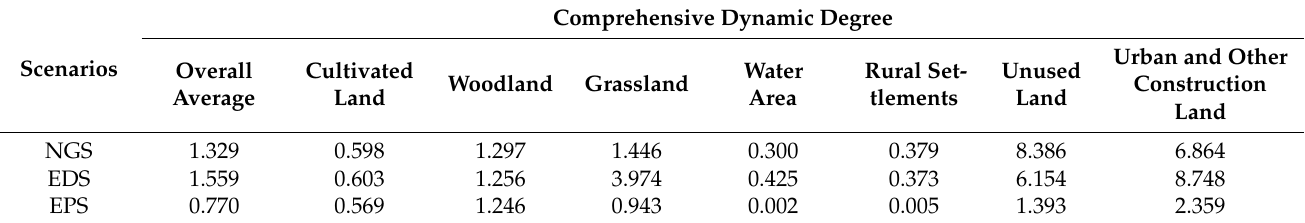
Table 4. Land use comprehensive dynamic degree under different